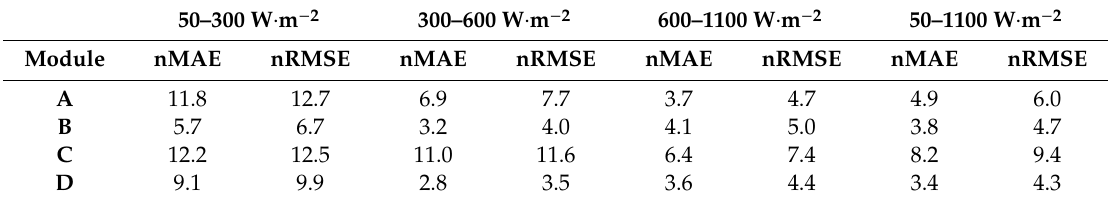
Table 7. Normalized nMAE and nRMSE on computed T c via [34], per irradiance range, in